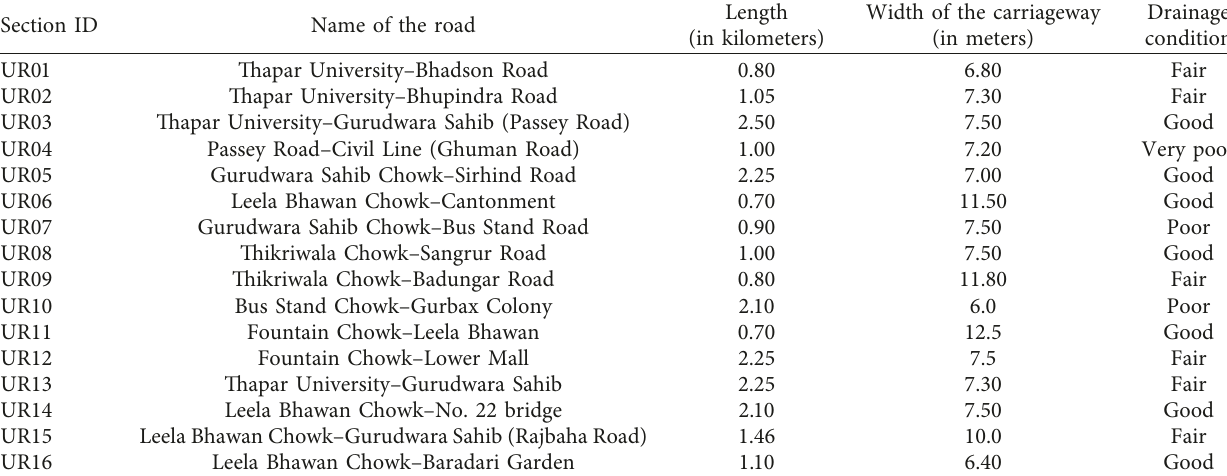
Table 1: Inventory data of selected road